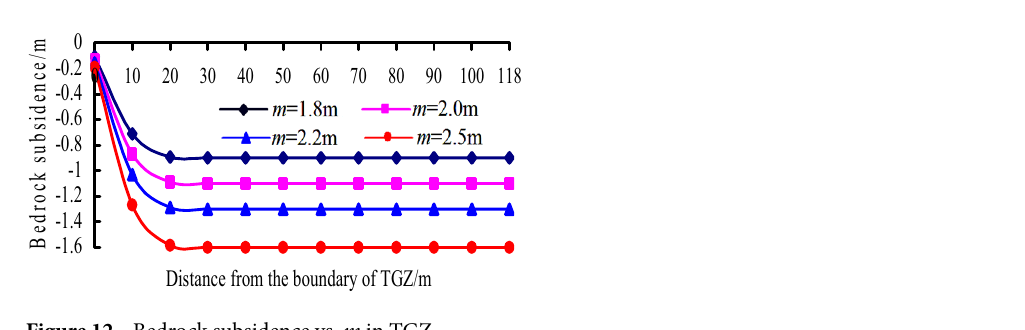
Figure 12. Bedrock subsidence vs. m in